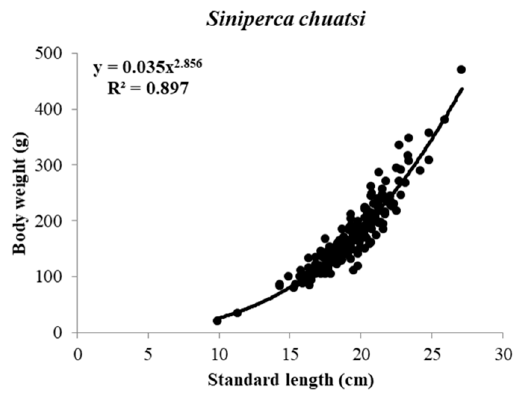
Figure 2. Curves of length–weight relationships (LRWs) based on the formula: BW = aSL b for 25 fish species in the midstream of the Jialing River sampled from December 2021 to November 2022, R 2 represents the coefficient of determination. Table 2. Descriptive statistics and regression parameters of length–weight relationships (LWRs) based on the formula: BW = aSL b for 25 fish species ( IRI ≥ 10) in the midstream of the Jialing River sampled from December 2021 to November 2022. n represents sample size, a and b are regression parameters, CI is the confidence interval for parameters, r 2 is the coefficient of determination, Type of growth is determined by comparing the significance of exponent b with 3, I represents isometric growth, A- represents negative allometric growth, A+ represents positive allometric growth.